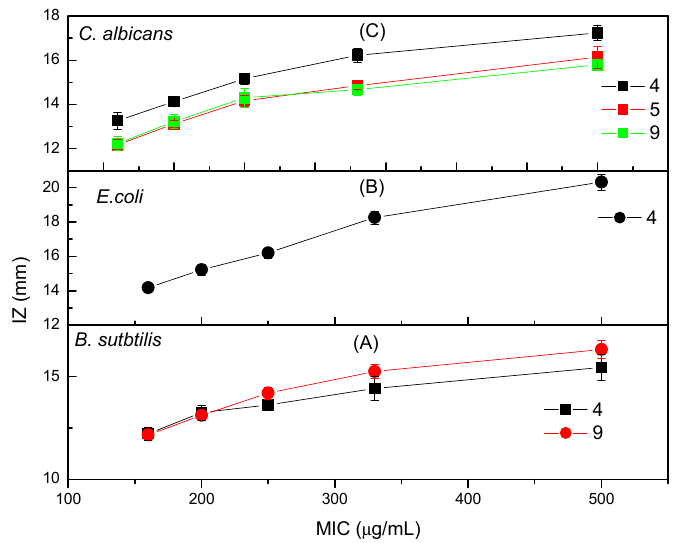
Figure 1. The minimum inhibitory concentrations (MICs) of Compounds 4 , 5 , and 9 against differently tested microorganisms expressed as inhibition zones of growth in millimeters.